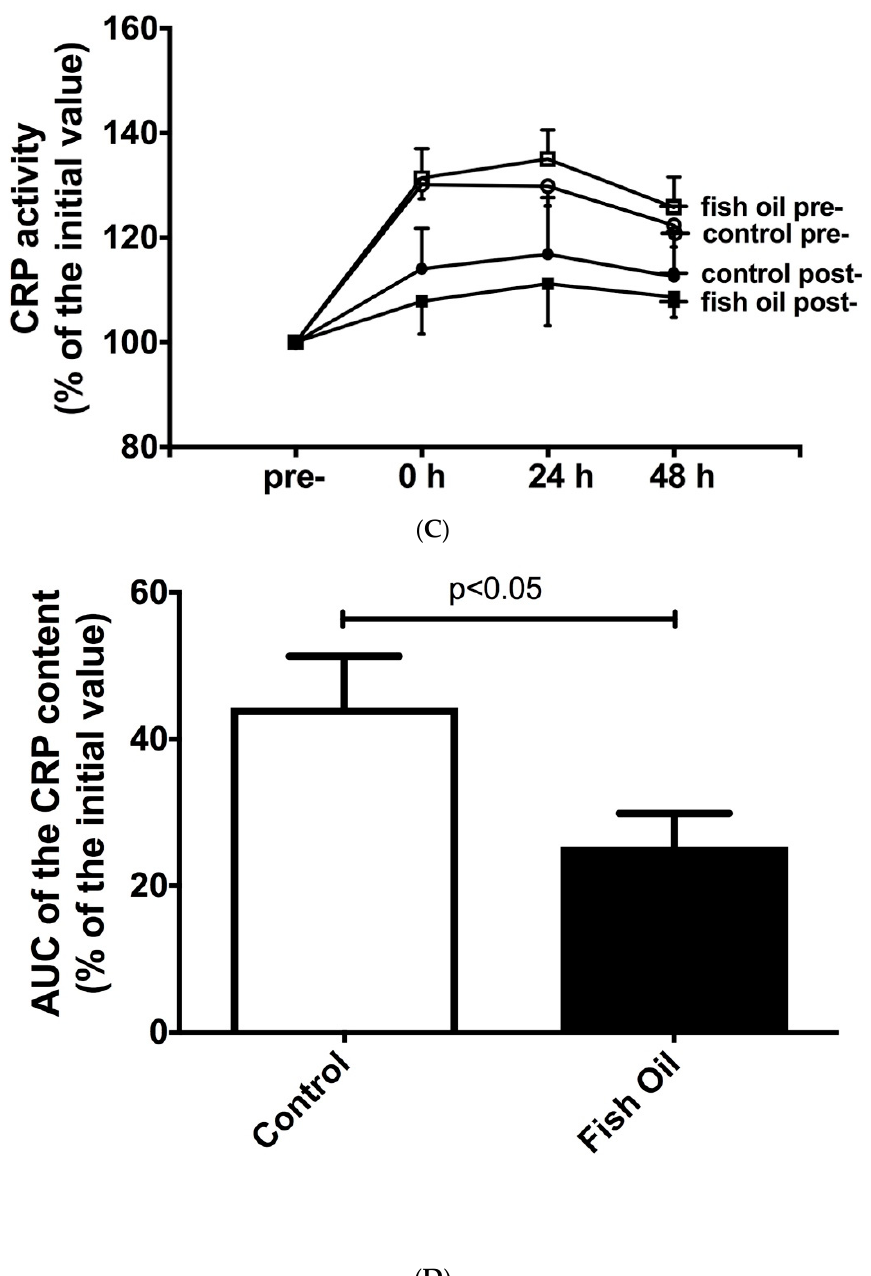
Figure 2. Effect of fish oil supplementation on plasma interlekin-6 (IL-6) ( A ) and C-reactive protein (CRP) ( C ) concentrations, in response to a single bout of strength exercises, at baseline (pre-training period) and after 6 weeks of non-linear strength training (post-training period). On the left, time- dependent plasma concentration (before and 0, 24, and 48 h after a single session of hypertrophic exercises). On the right, reduction in the area under curve (AUC) of the temporal plasma concentra- tions of IL-6 ( B ) and CRP ( D ) after 6 weeks of daily undulating training, associated or not with fi sh oil supplementation. Results presented as mean ± S.E.M. p < 0.02 for IL-6, and p < 0.05 for CRP, comparing control group with fi sh oil group.